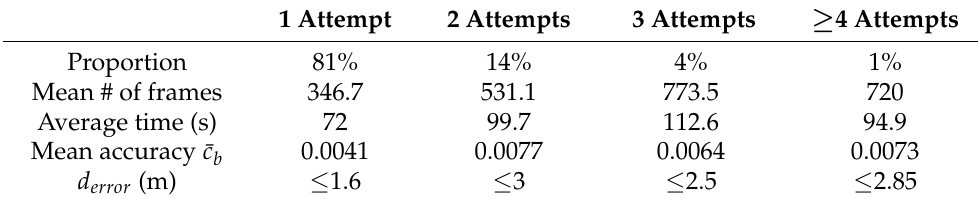
Table 3. Statistical results of Monte Carlo 100